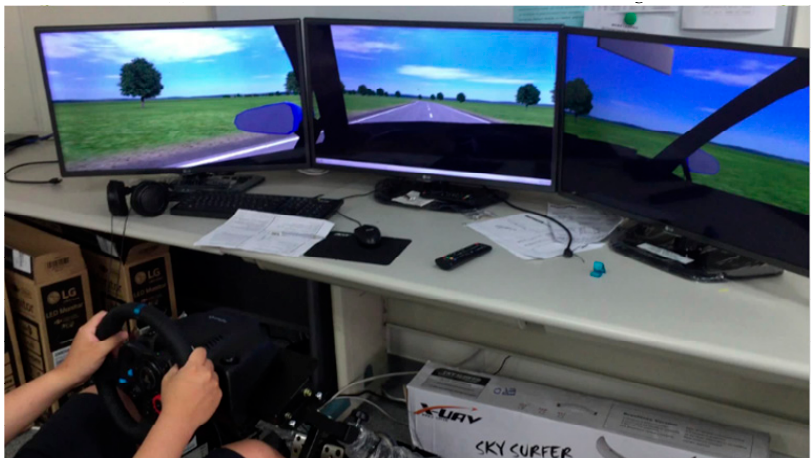
Figure 8. Environmental setup of the evaluations. Appl. Sci. 2016 , 6 , 327